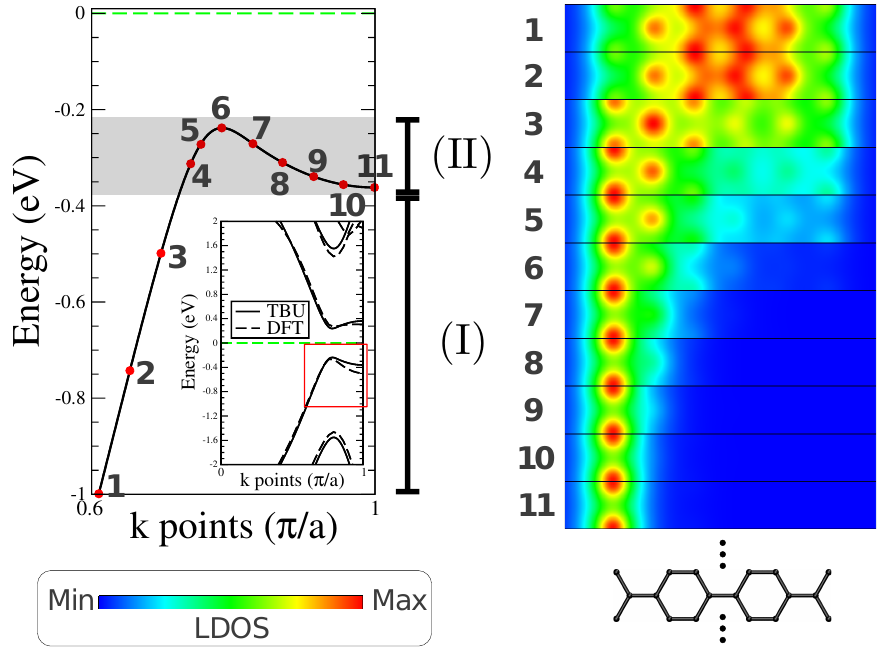
Figure 3. Dispersion relation for the highest occupied band for a zGNR-6 in its AFM state. Regions (I) (highlighted in gray) and (II) are indicated accordingly. The inset shows a comparison between DFT and tight-binding description (TBU) for a broader range of energy and local density of states (LDOS) for selected values of the the k vector along the ribbon’s